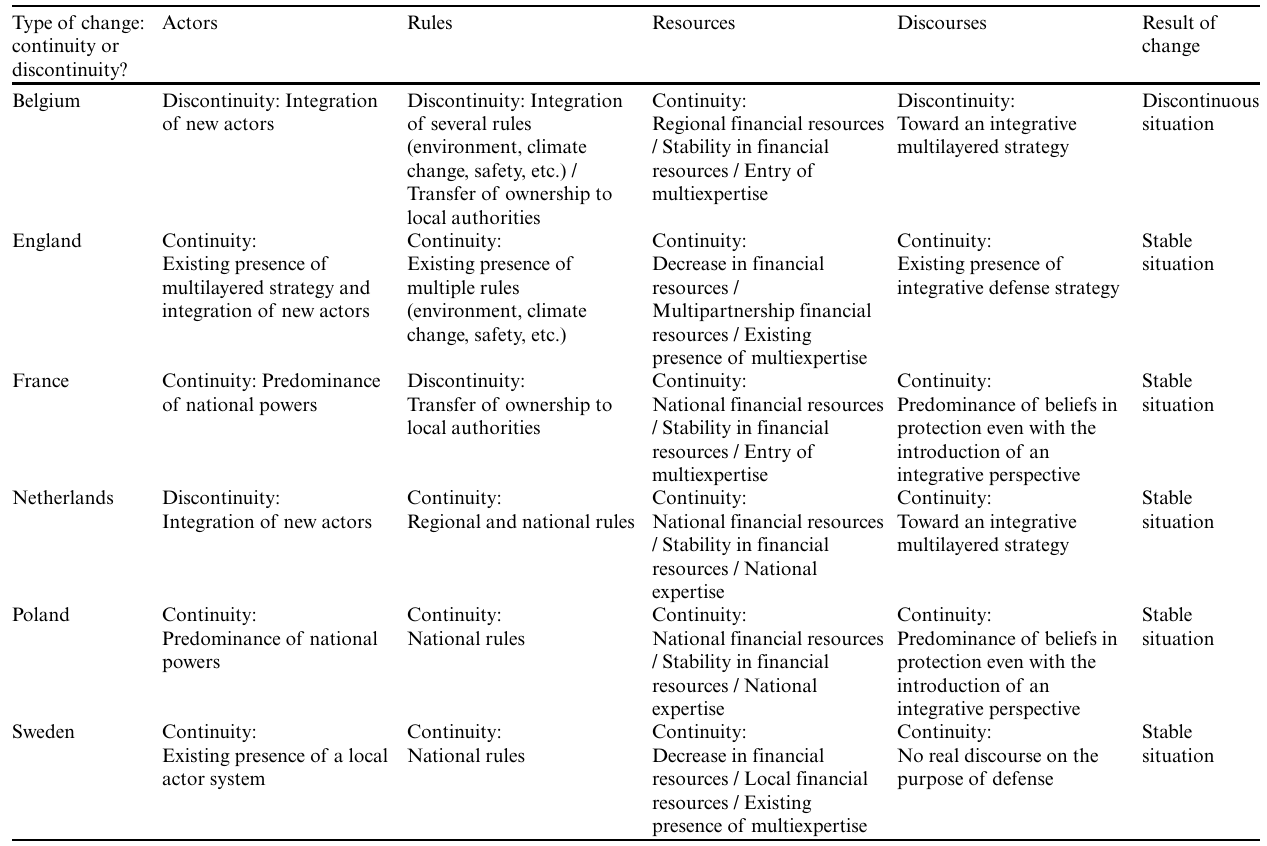
Table 3 . Main outcomes from the dynamics of change for each